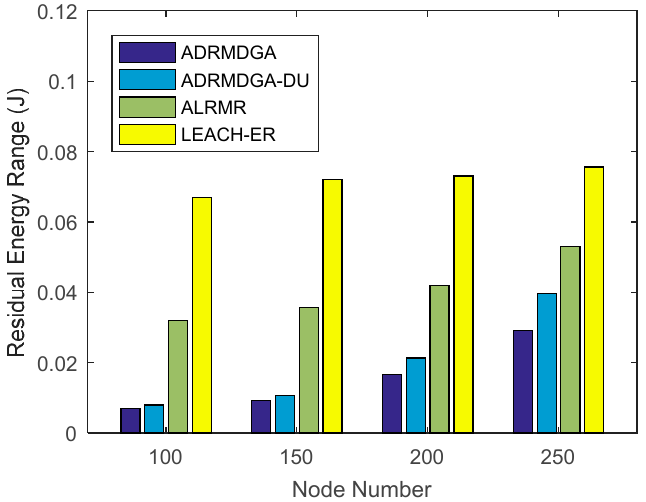
Figure 7. Impact of node number on residual energy range in different algorithms (P = 0.3 W).